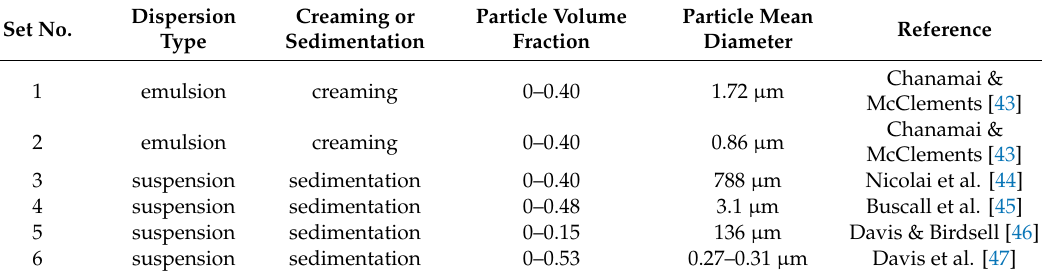
Table 1. Six sets of creaming / sedimentation data taken from di ff erent sources. Set